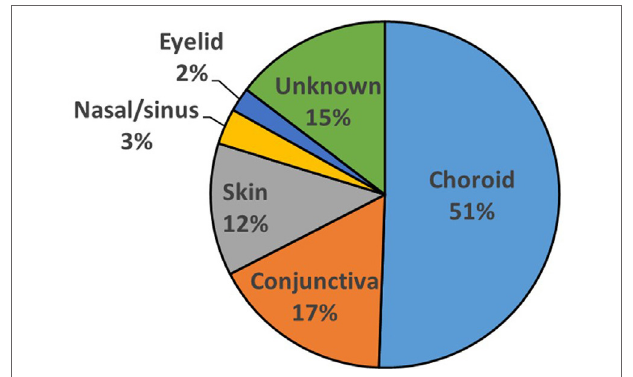
patient group: first, orbital involvement tends to occur either early ( < 1 year after primary disease) or late at many years after primary disease ( Figure 2 ). Second, there was a group of patients with an unusually long survival after the diagnosis of melanoma recurrence within the